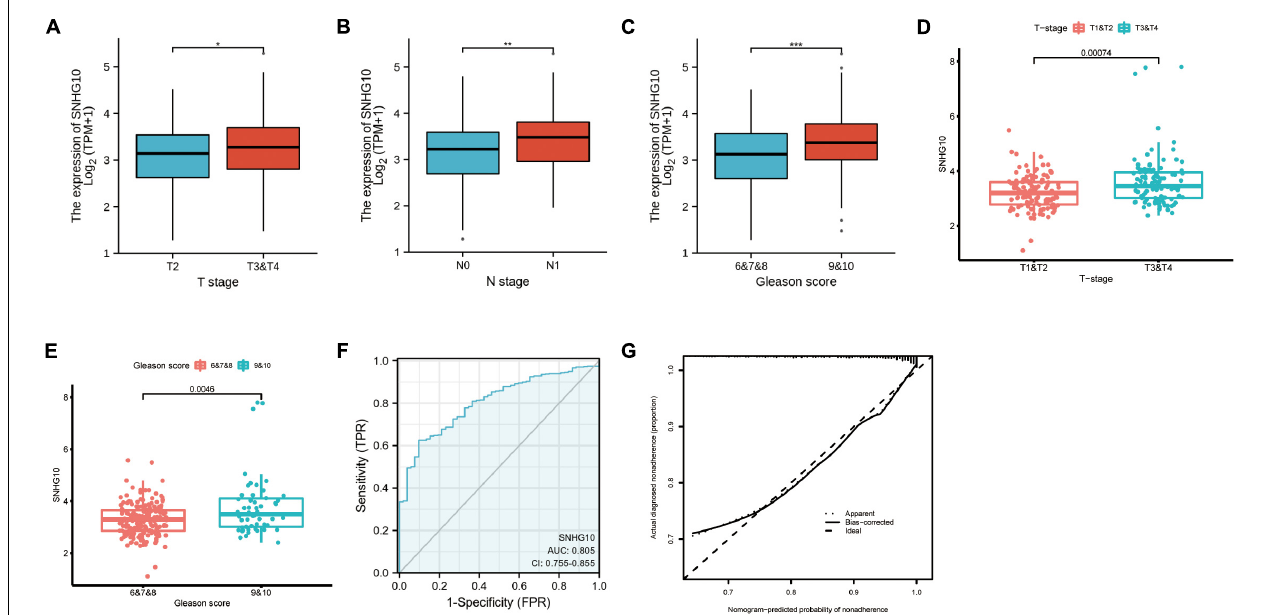
FIGURE 3 | SNHG10 was associated with clinical parameters in PC. SNHG10 expression levels among PC patients with different (A) T stage, (B) N stage, and (C) Gleason score in TCGA-PRAD. SNHG10 expression levels with different (D) T stage, (E) Gleason score in GSE116918. (F) Diagnostic efficacy of the ROC curve of SNHG10 expression in TCGA-PRAD. (G) Calibration curves of SNGH10 expression in TCGA-PRAD. ROC, receiver operating characteristic; AUC, area under the ROC curve; CI, confidence interval. * P < 0.05, ** P < 0.01, and *** P < 0.001.